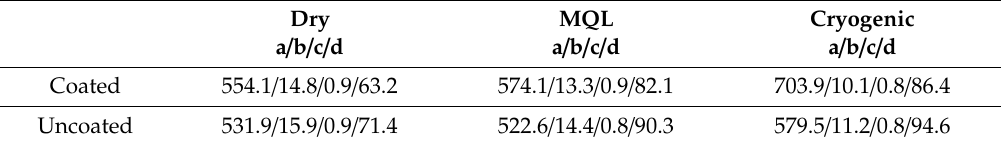
Figure 6. Residual plots for hardness.